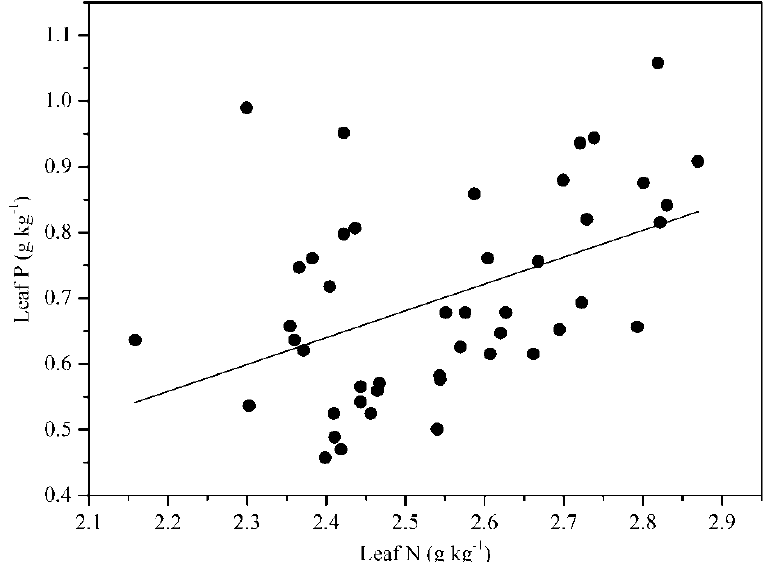
Figure 2. Relationships between the leaf N and P concentrations for Chinese fir in the study. Each data point represents an ln (N + 1)-transformed leaf N or P concentration. Linear regressions are shown for the leaf N and P ( R 2 = 0.19, p < 0.01).